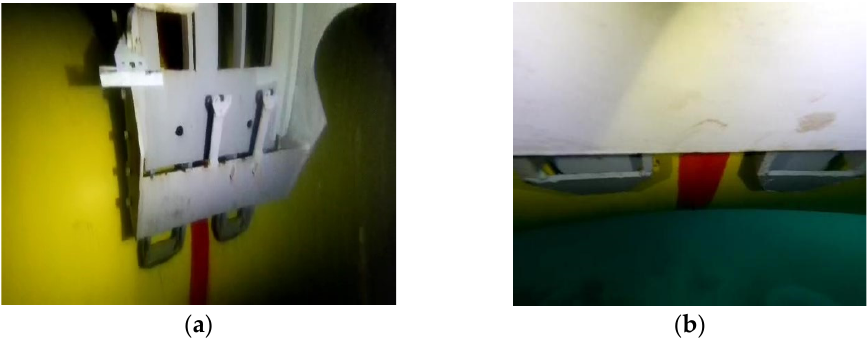
Figure 17. Butting and locking test: ( a ) Claw tips stretched out and ( b ) Claw tips further stretched out to the bottom of the object.